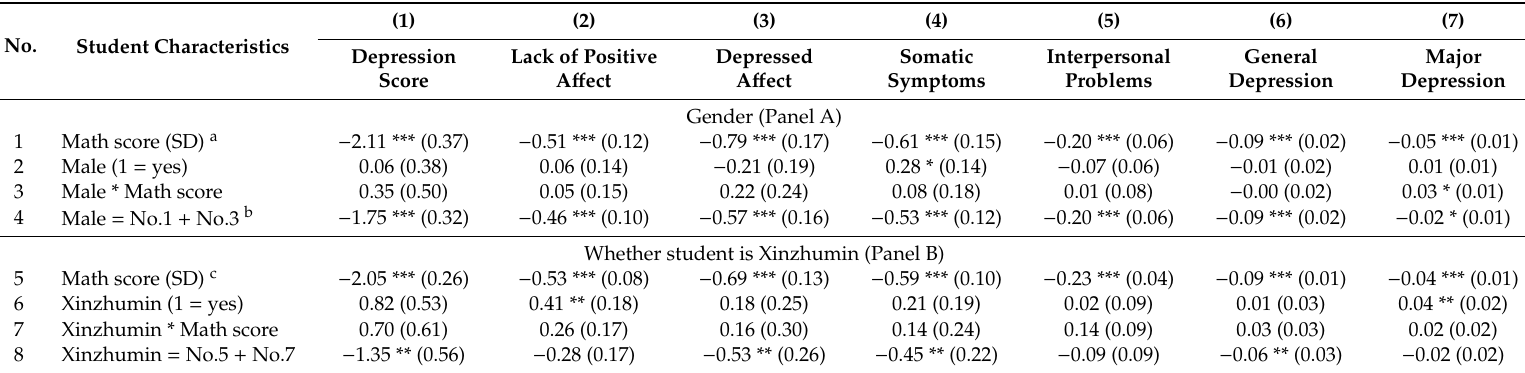
Table 5. OLS regression results showing heterogeneous e ff ects of academic performance on depressive symptoms across gender and Xinzhumin status, N = 1655. No.